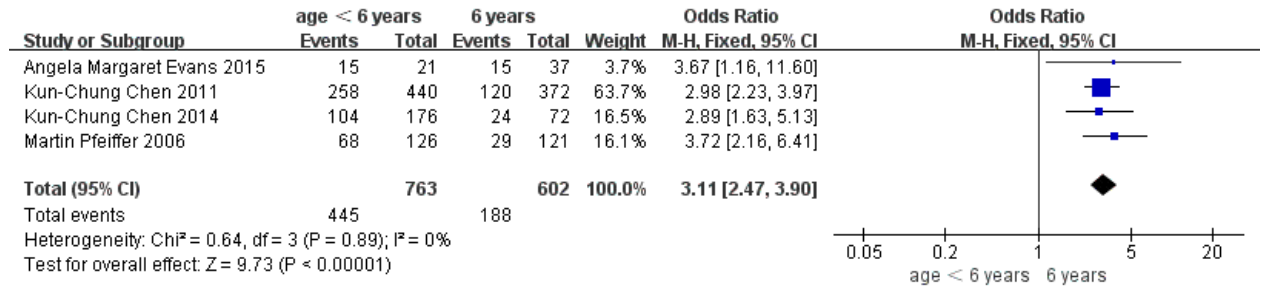
Figure 2. The forest plot of age <6 years for flatfoot in children [8,12,14,17].